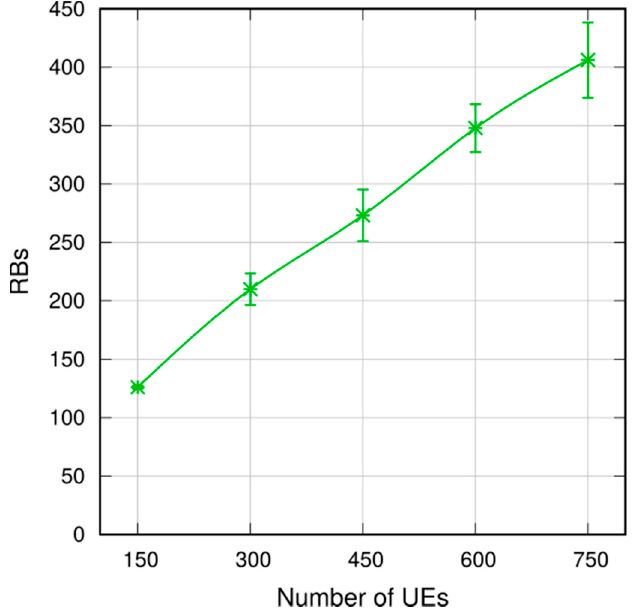
Figure 23. Avg. allocated RBs per broadcast, dense scenarios.